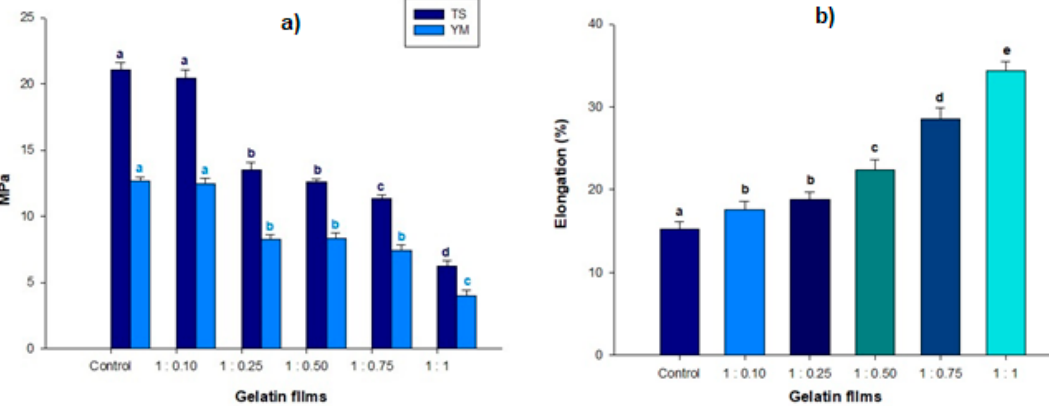
Figure 3. Mechanical properties of the different films with W/O nanoemulsions (control, 1:0.10, 1:0.25, 1:0.50, 1:0.75, and 1:1). ( a ) Dark blue bars indicate Young’s modulus (YM) in gelatine films and light blue bars indicate tensile strength in films where results are expressed in mega pascals (MPa). ( b ) The bars indicate the percentage of elongation in the gelatine films. a,b,c,d,e Different letters mean statistically different values according to the Tukey test ( p < 0.05).